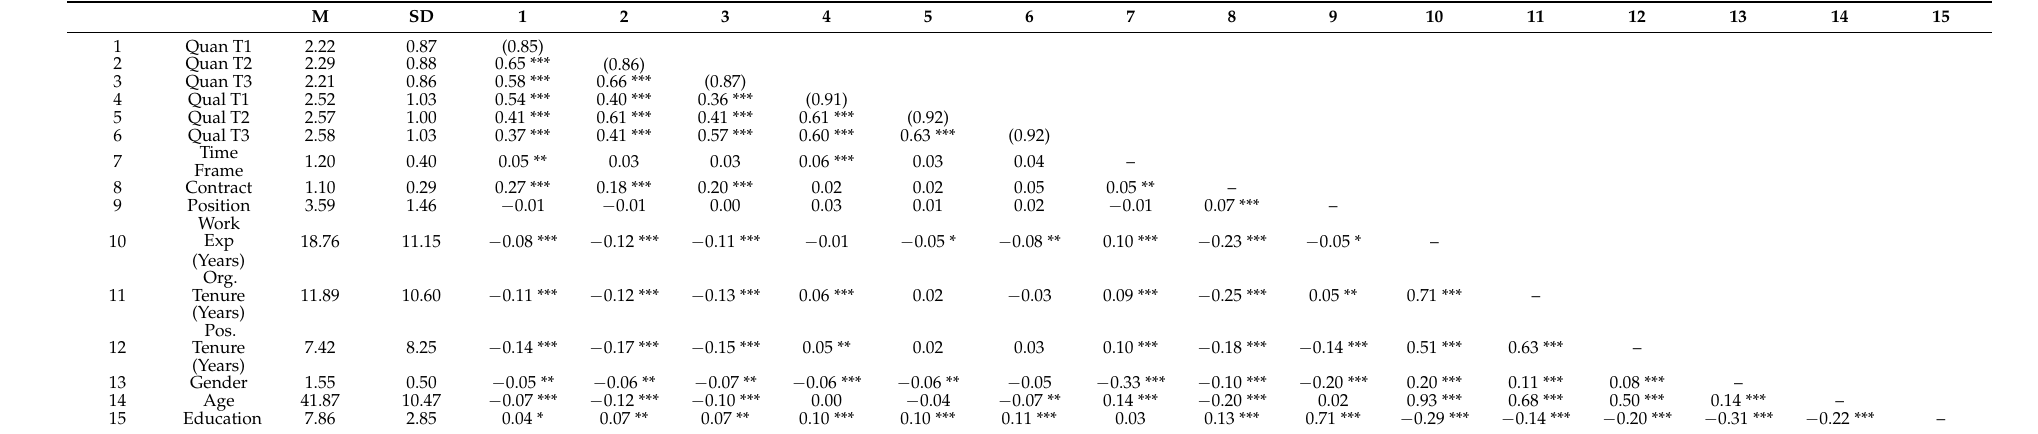
Table 1. Means, standard deviations, reliability (Cronbach’s alpha in parentheses), and